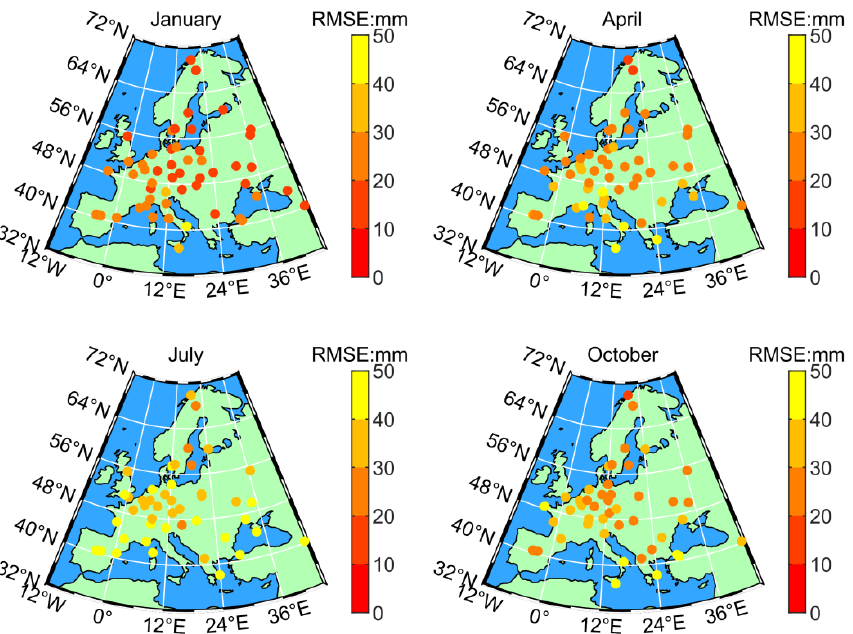
Figure 6. RMSE values of ERA5S-ZTD at all available IGS stations in January, April, July, and October of 2018. These RMSE values of ERA5S-ZTD are concentrating in the range of 25–50 mm.